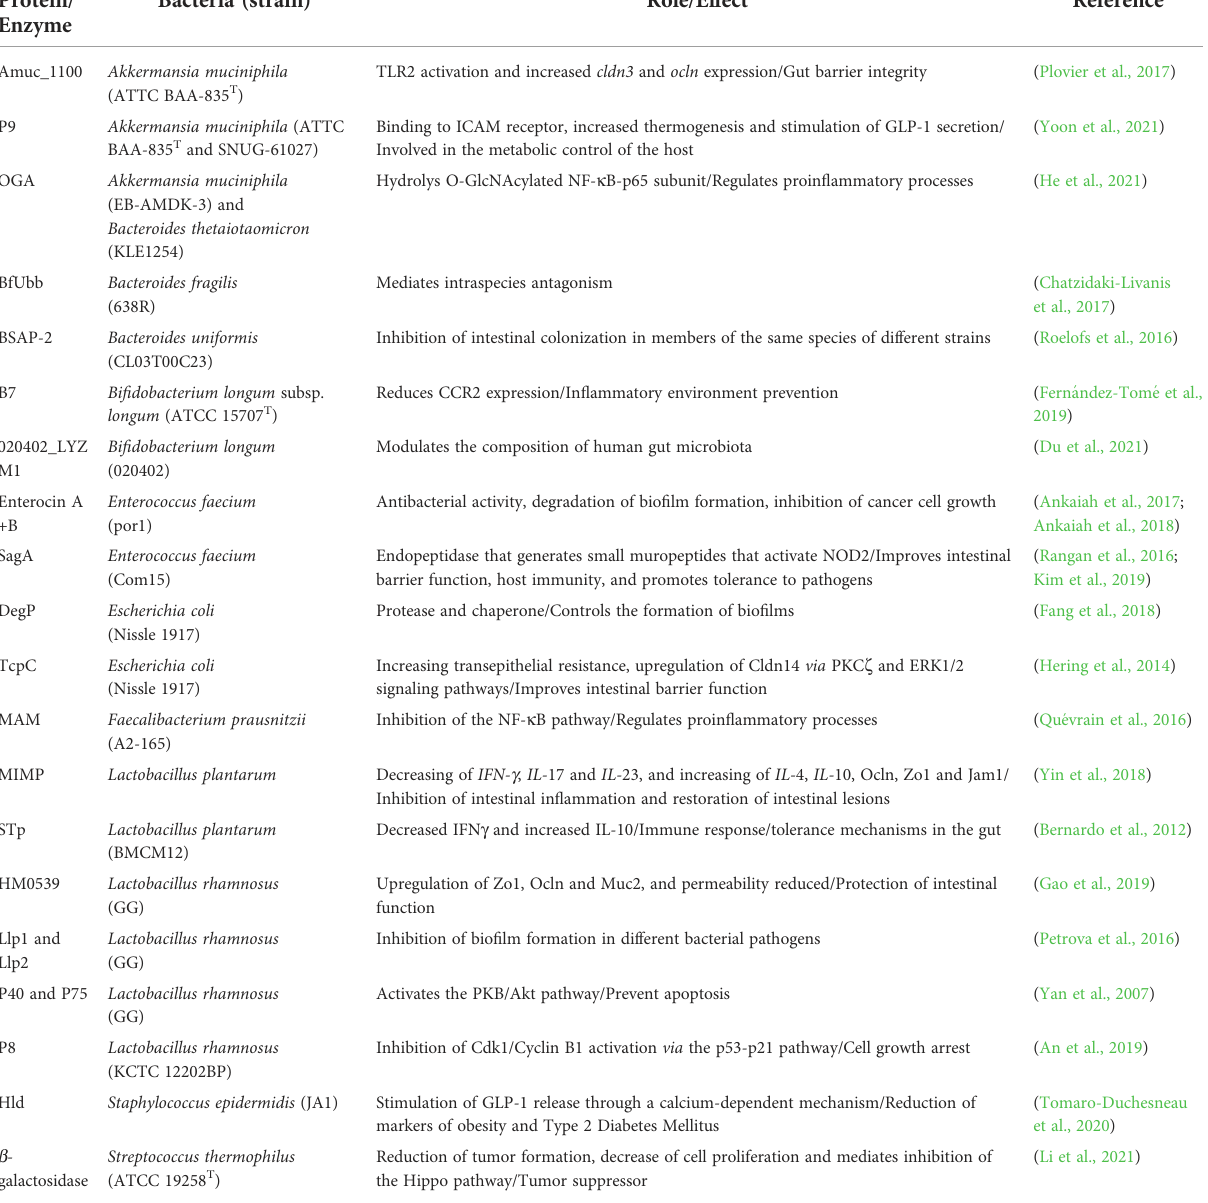
TABLE 1 Studied proteins and enzymes found in commensals and probiotics bacterial intestinal. Protein/ Bacteria Enzyme